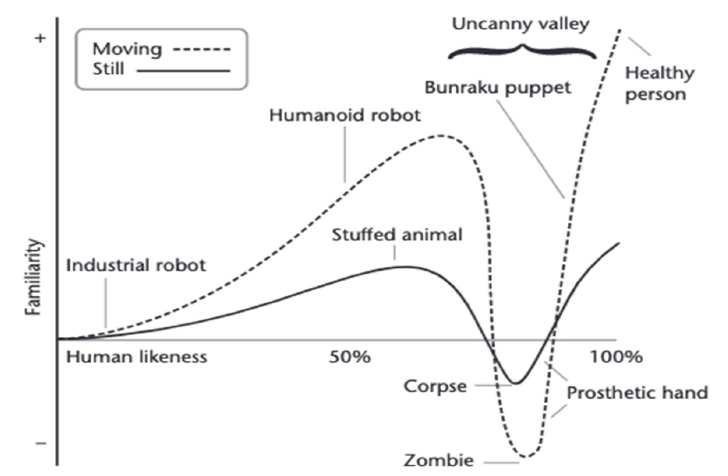
Figure 2. Uncanny Valley. Source: Geller (2008).